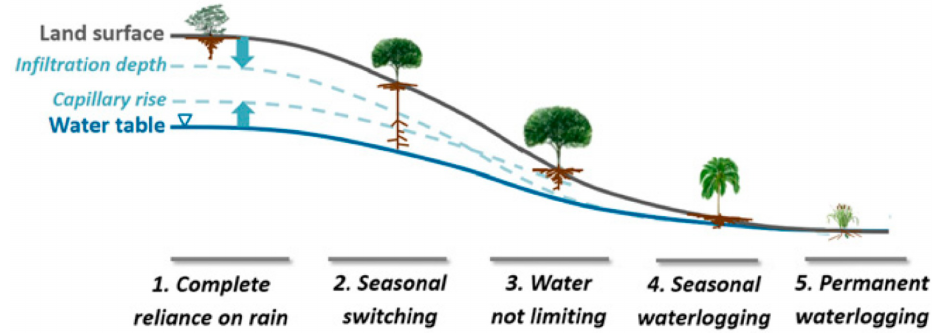
Figure 1. The variation of plant rooting depths along a hillslope profile, showing the impact of HAND (Height Above the Nearest Drainage) on rooting depth (Taken from Fan et al., 2017 by permission of